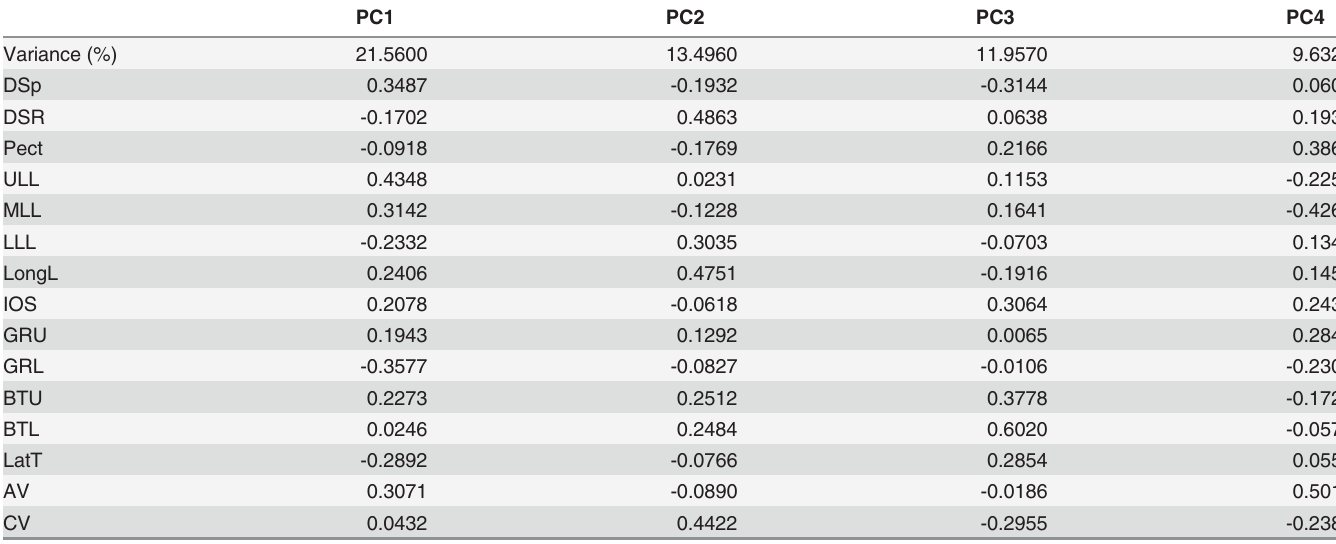
Table 5. PCA on meristics of S . babaulti and S . pleurospilus .